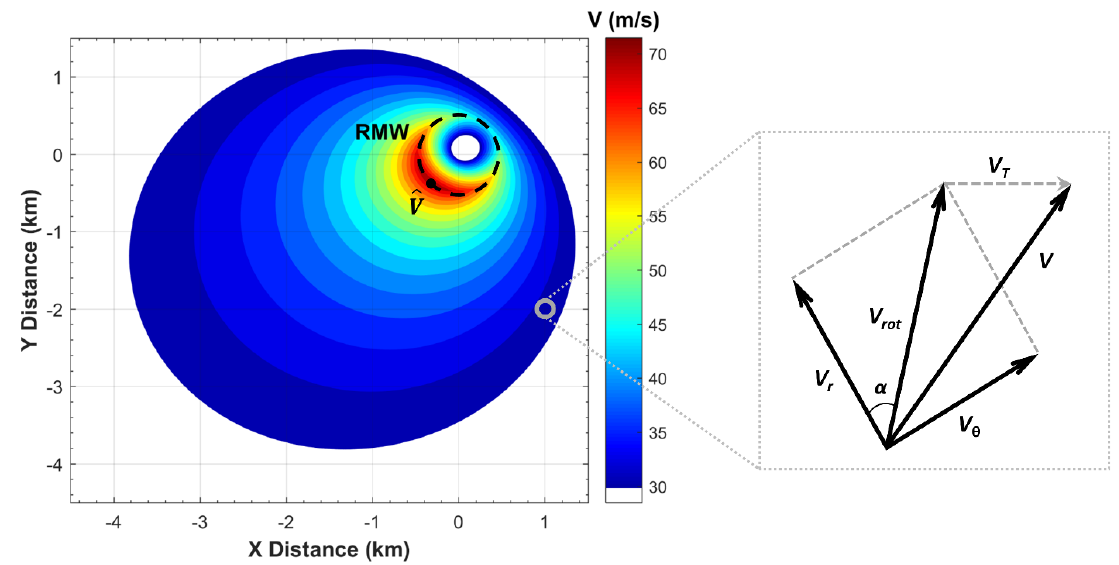
Figure 1. Wind field of a left to right translating vortex with V T = 13 m/s, G max = 4.5, RMW = 483 m, α = 45°, φ = 0.55 ( Left ) and decomposition of the velocity components of the Rankine vortex model ( Right ) (after [28]).